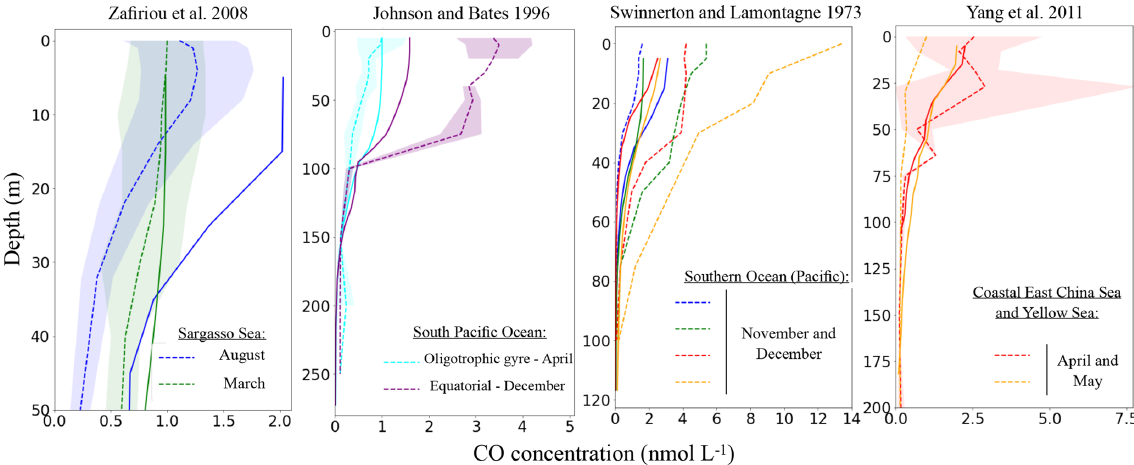
Figure 7. Comparison of simulated oceanic CO profiles with the measured profiles (simulated profiles for the same months and location as measurement). Only a few datasets are shown in this figure (others are available in the Supplement). Dotted lines represent the observed profiles and continuous lines the model output. The standard deviation of the observation, when available, is shown around each observed profile with the shaded area of the same